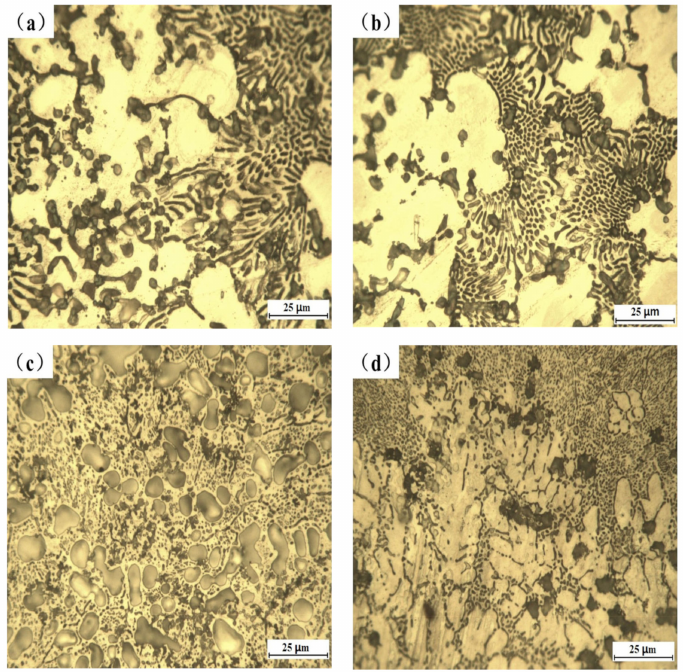
Figure 3. Optical micromorphology of cladded samples: ( a ) AS, ( b ) AS1Y, ( c ) AS1.5Y, and ( d )